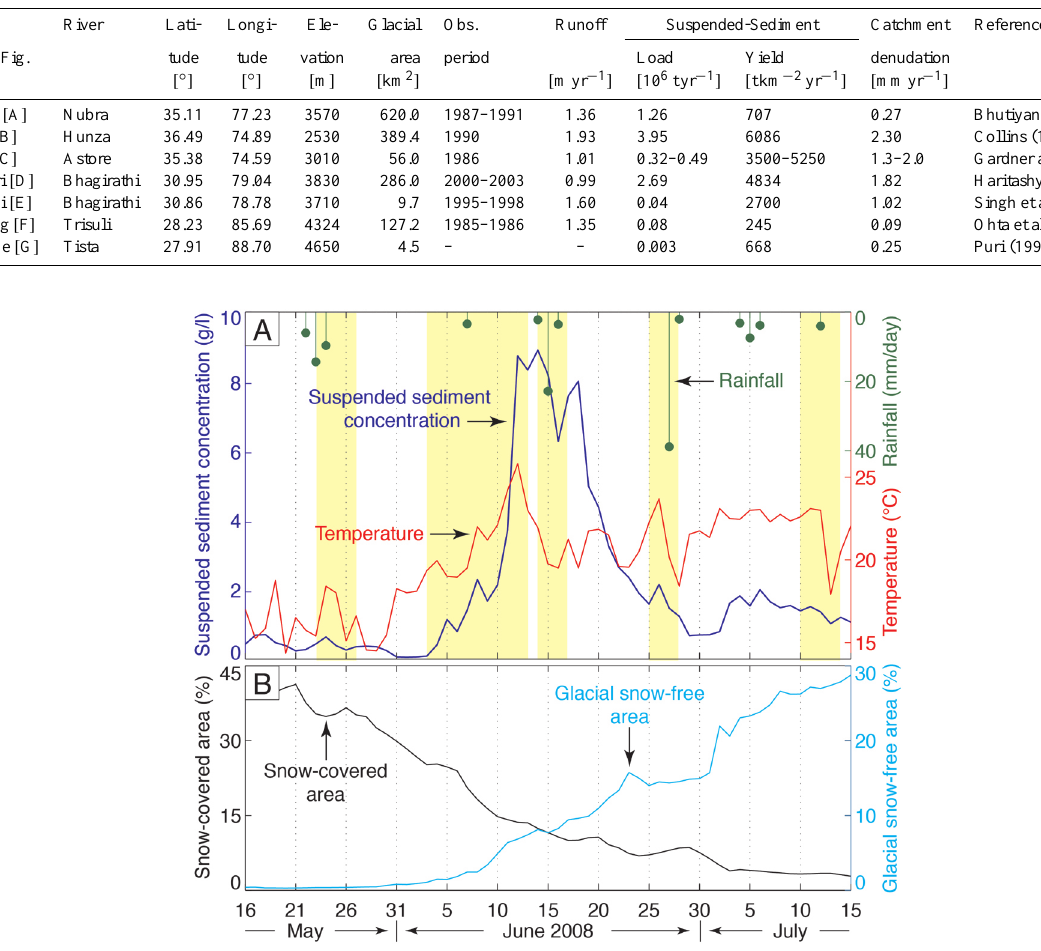
Fig. 10. (A) Comparison of SSC in the Spiti River with TRMM 3B42 rainfall averaged over the Spiti catchment and mean daily air tem- perature data from Namgia (cf. Fig. 1a) during a 2-month period in mid-2008. Yellow background indicates periods of positive correlation ( r 2 =0.68) between SSC and temperature variations. (B) Percentage of snow-covered area and the percentage of glacial snow-free area in the Spiti catchment for the same